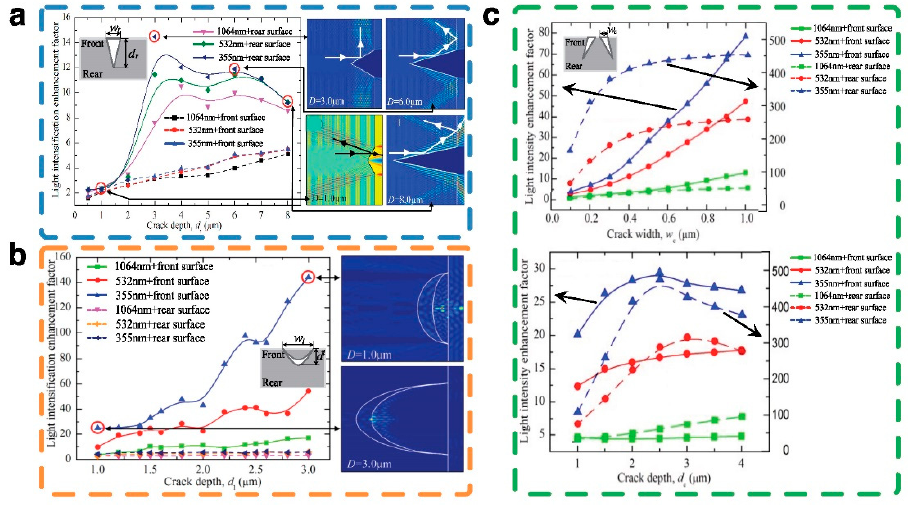
Figure 13. Influence of size parameter of surface cracks on light intensity under the irradiation of 1064 nm, 532 nm, and 355 nm lasers. ( a ) Radial cracks; ( b ) Lateral cracks; ( c ) Conical cracks [18]. Correspondingly, Cheng et al. [18] used the R-on-1 laser irradiation mode to detect the surface LIDT of KDP crystals with di ff erent kinds of cracks, as shown in Figure 14. The cracks were established based on the exploration of references [18,81,82].